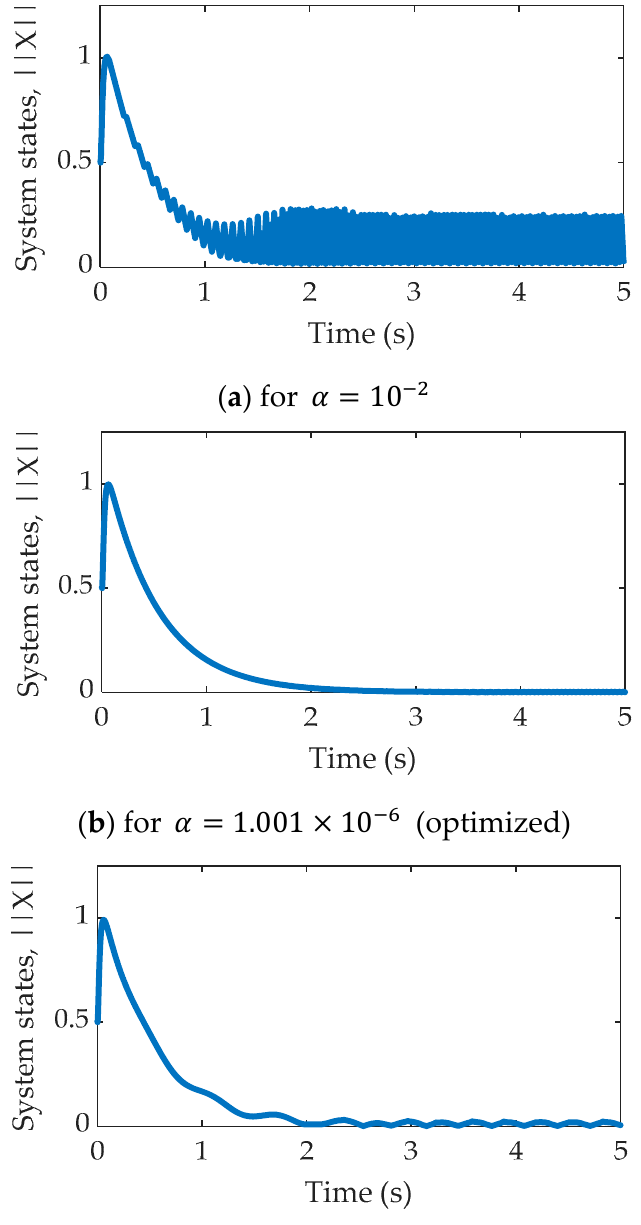
Figure 6. Single-link robot system states, ‖(cid:1850)‖ .